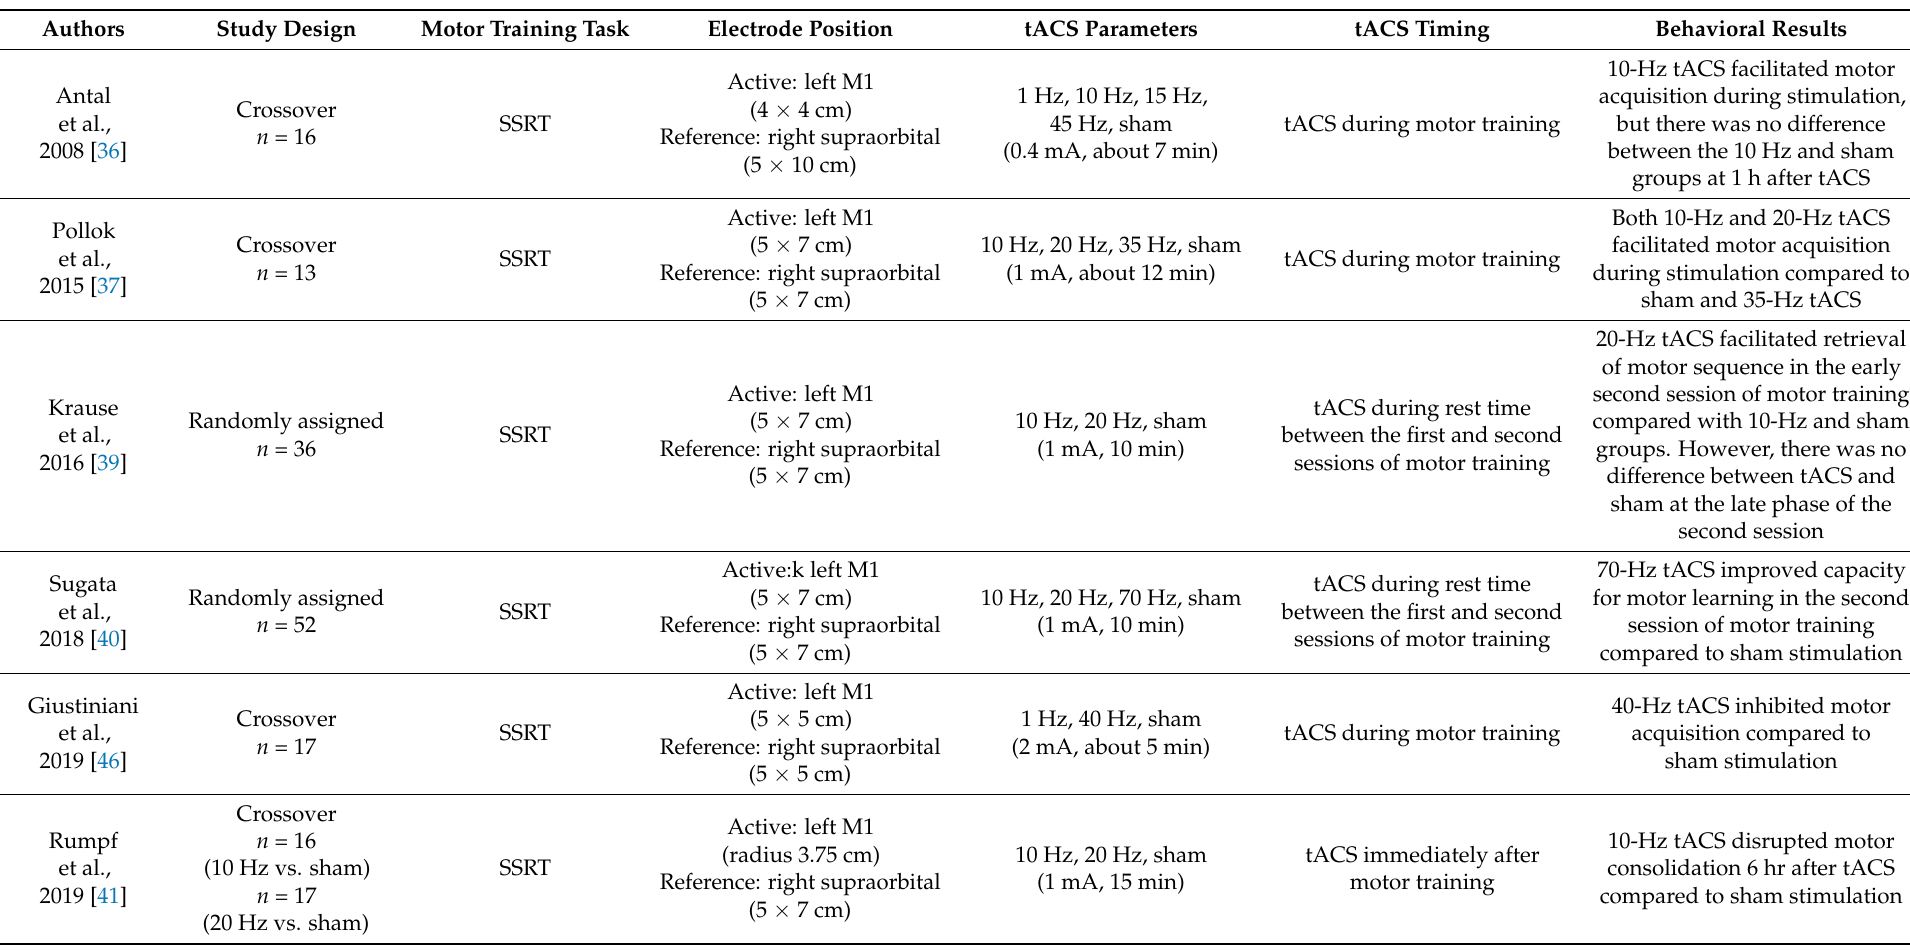
Table 1. Summary of studies applying tACS over the primary motor cortex